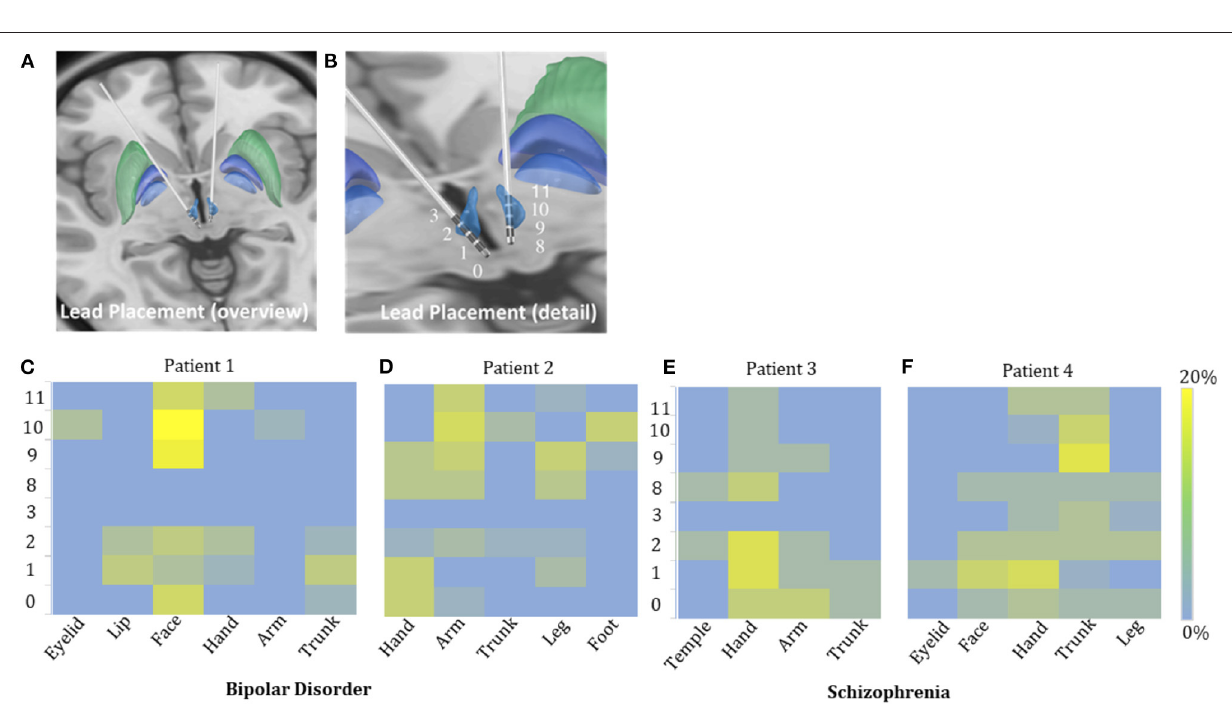
parts in these four patients were face (26 out of 35 = 74.3%), arm (19 out of 41 = 46.3%), hand (13 out of 22 = 59.1%) and trunk (26 out of 48 = 54.2%), respectively ( Figures 2C–F